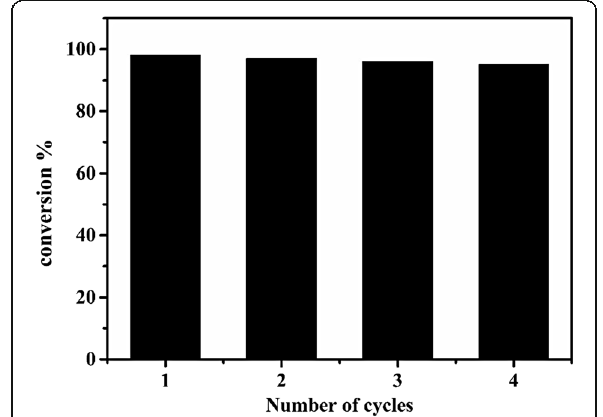
Fig. 13 Plot of percentage of conversion (4-NP to 4-AP) vs Number of